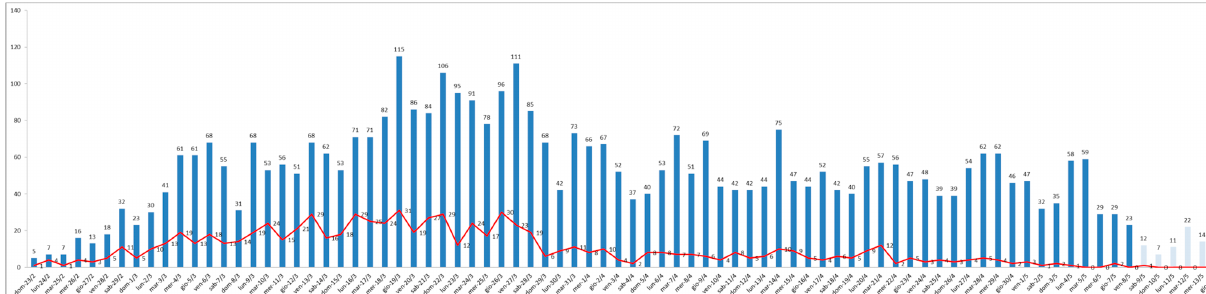
Figure 1. Trend of the number of COVID-19 admissions and corresponding deaths per day (red line).